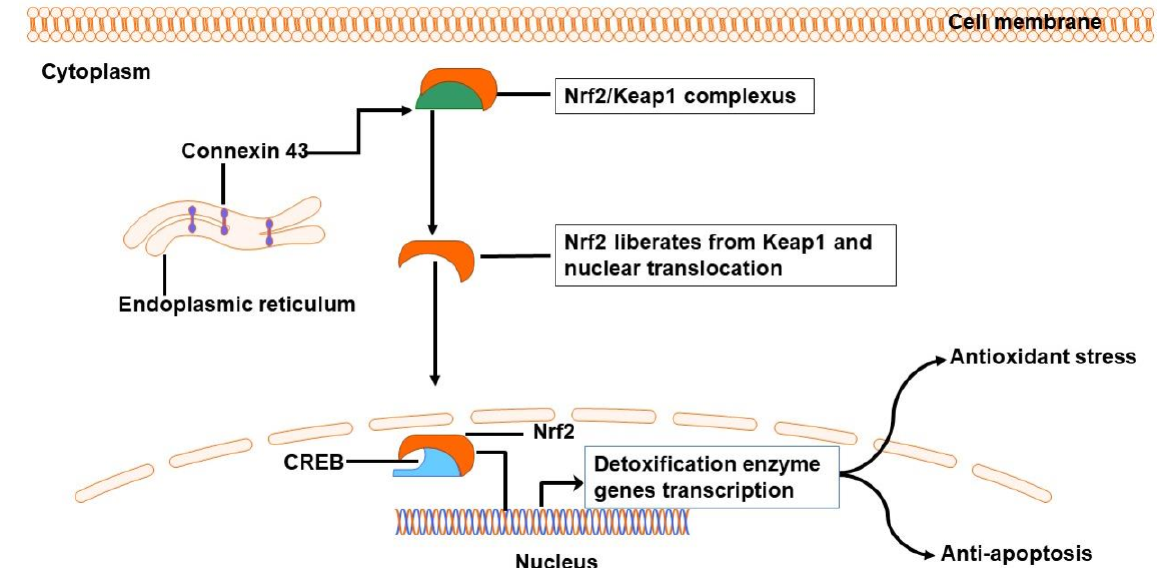
Figure 2. Possible mechanism by which astrocyte Cx43 resists oxidative stress following ICH. Cx43 from endoplasmic reticulum helps liberate Nrf2 from Keap1 and allows its nuclear translocation, promoting phase II detoxification enzyme genes involved in antioxidant stress and anti-apoptosis. ICH, intracerebral hemorrhage; Cx43, connexin 43; OS, oxidative stress; Nrf2, nuclear factor erythroid 2-related factor 2; CREB, cAMP-response element-binding